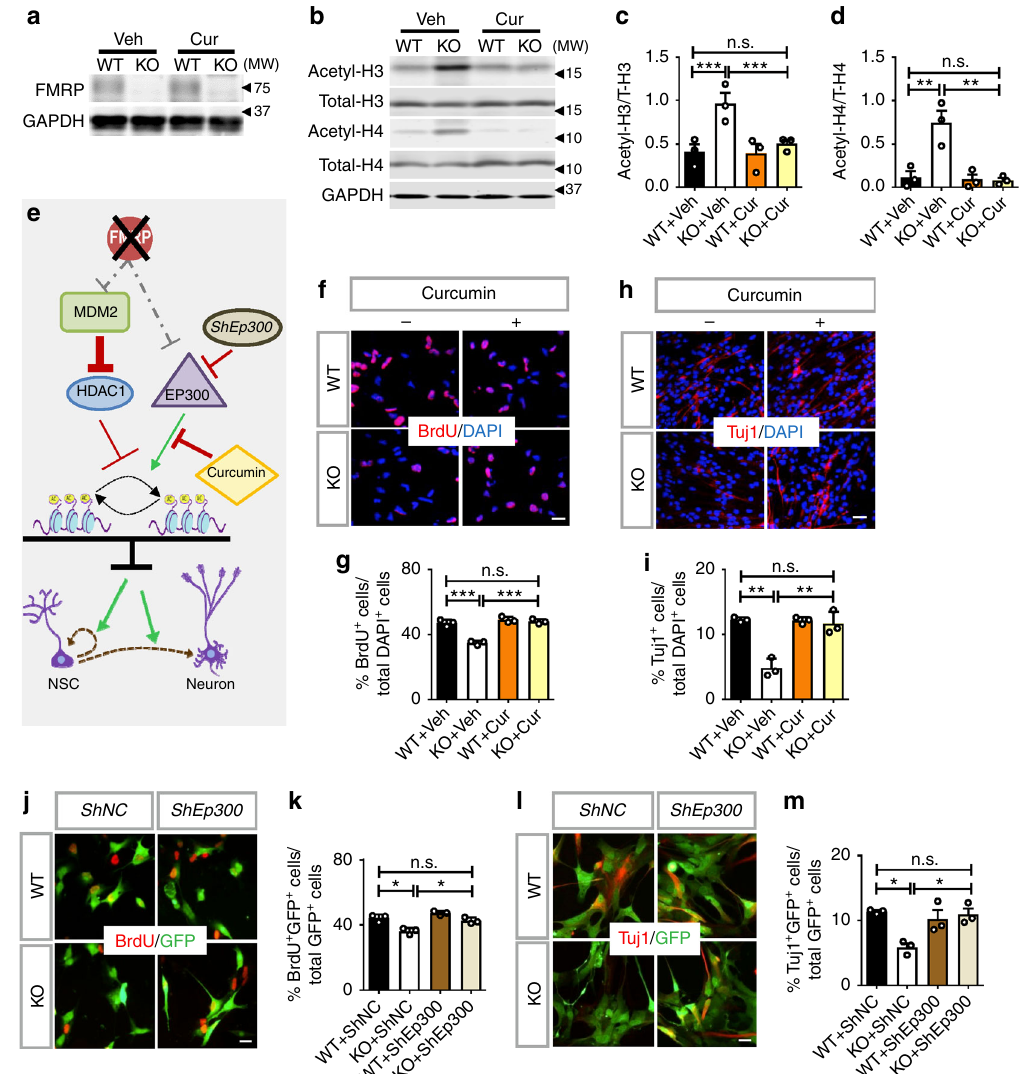
Fig. 4 Reducing EP300 activities rebalances histone acetylation and rescues proliferation and differentiation de fi cits of FMRP-de fi cient NPCs. a FMRP protein expression in primary Fmr1 KO and WT NPCs treated with vehicle or curcumin (Cur). b A schematic model showing that reducing EP300 activities either pharmacologically or genetically rebalances histone acetylation and rescues proliferation and differentiation of Fmr1 KO NPCs. c – e Western blot analyses of total and acetylation of histone H3 ( c , d ) and histone H4 ( c , e ) in NPCs treated with curcumin ( n = 3). Total histone H3 and total histone H4 were used as loading controls for acetylated H3 and H4, respectively. f , g Curcumin treatment rescued the cell proliferation phenotype of Fmr1 KO NPCs as assessed by incorporation of the thymidine analog, BrdU ( f , red, BrdU; blue, DAPI. scale bar, 20 µ m) and quantitative analysis ( g , n = 3). h , i Curcumin treatment rescued neuronal differentiation phenotypes of Fmr1 KO NPCs as assessed by a neuronal marker Tuj1 + ( h , red, Tuj1; blue, DAPI. scale bar, 20 µ m) followed by quantitative analysis ( i , n = 3). j , k Acute knockdown of EP300 rescued the cell proliferation phenotype of Fmr1 KO NPCs as assessed by incorporation of the thymidine analog, BrdU ( j , red, BrdU; green, GFP, scale bar, 20 µ m) and quantitative analysis ( k , n = 3). l , m Acute knockdown of EP300 rescued neuronal differentiation phenotypes of Fmr1 KO NPCs as assessed by a neuronal marker Tuj1 + ( l , red, Tuj1; green, GFP, scale bar, 20 µ m) followed by quantitative analysis ( m , n = 3). * P < 0.05, ** P < 0.01, *** P < 0.001. n.s.: no signi fi cant difference. Two-way ANOVAs were used for data analyses. Data are presented as mean ±